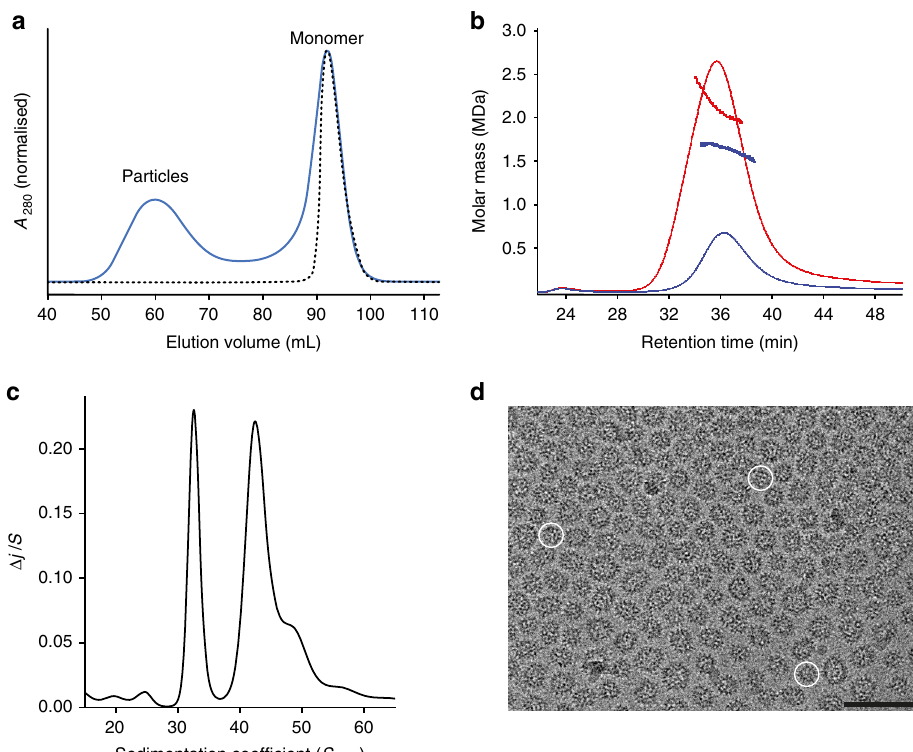
Fig. 1 Hydrodynamic and EM analysis of HML2 CA rec particles. a Gel fi ltration chromatogram ( A 280 ) of an HML2 CA rec assembly reaction (1.4 M NaCl; solid blue line) and the unassembled monomer (0.1 M NaCl; dashed black line) separated on a Superose 6 16/60 GL column. The peaks containing HML2 CA rec monomer and early eluting assembled particles are labelled. b Solution molecular mass of HML2 CA rec particles. The molar mass distribution of HML2 CA rec particles analysed by SEC-MALLS employing a Superose 6 10/30 column equilibrated in 1 M NaCl. The chromatograms were recorded from the 90° detector of the photometer from samples of HML2 CA rec assembly reactions carried out at 2 mg mL − 1 (blue) and 10 mg mL − 1 (red). The points, colour-coded the same as the chromatograms, are the molar mass measured at 1-s intervals throughout the elution of the chromatographic peaks and show the presence of heterogeneous species ranging from 1.5 to 3.0 MDa. c Continuous distribution function of sedimentation coef fi cients. The plot shows the 20 – 60S region derived from sedimentation velocity analysis of a HML2 CA rec particle preparation. HML2 CA rec particles with sedimentation coef fi cients of 32S, 42S and 50S are the major species. d Cryo-electron micrograph of a fi eld of HML2 CA rec particles showing a predominance of small (T = 1) particles (circled examples) and larger capsular particles, scale bar is 50